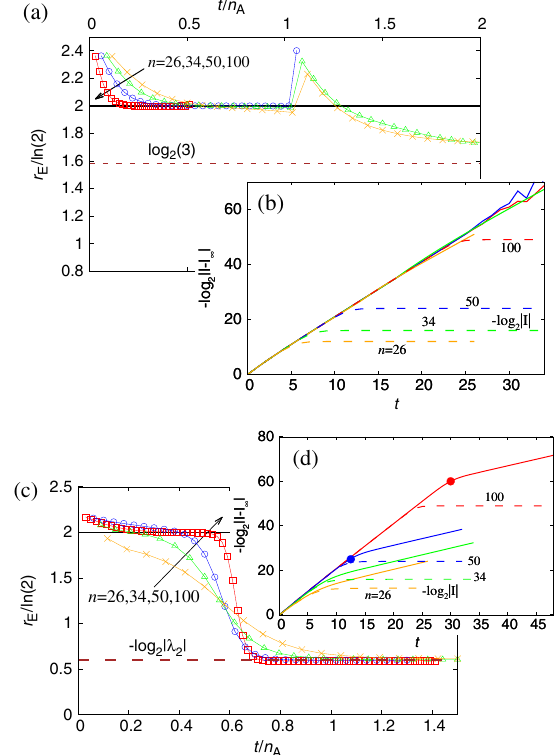
FIG. 12. Spectrum of M for S and PBC, a There are n − 1 eigenvalues with j λ j j → 1 FIG. 10. (a,b) Entanglement rate for the S configuration with larger (orange) circle] and ð n − 1 Þð n − 4 Þ = 2 with j λ j j → 1 0 , and (c,d) a 0 . 5 . At a 0 , the rate is always PBC and a z ¼ z ¼ z ¼ [smaller red circle; each visible point is composed of ð n − r 2 ln 2 , and it is larger than − ln j λ a , there is a 2 j . At nonzero E ¼ z 4 Þ = 2 close eigenvalues]. The leading contribution to I ð t Þ comes phase transition from r ln 4 for t < t to − ln j λ 2 j at larger E ¼ c from one eigenvalue with λ k ¼ 1 times. The transition appears to happen at larger t=n than 0.5 A =n ≈ 0 . 6 ). The brown dashed line at 0.60 is in eigenvalues with λ k ¼ 1 (here, around t c A degenerate line with j λ 2 j ≈ 0 . 66 from Fig. 4.